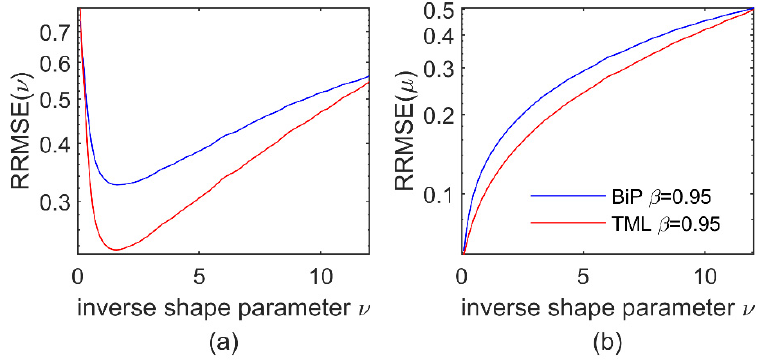
Figure 5. RRMSE comparison of the BiP and TML estimators with β = 0.95 in the case with outliers, where υ alters from 0.1 to 15: ( a ) RRMSEs of the inverse shape parameter; ( b ) RRMSEs of the scale parameter.